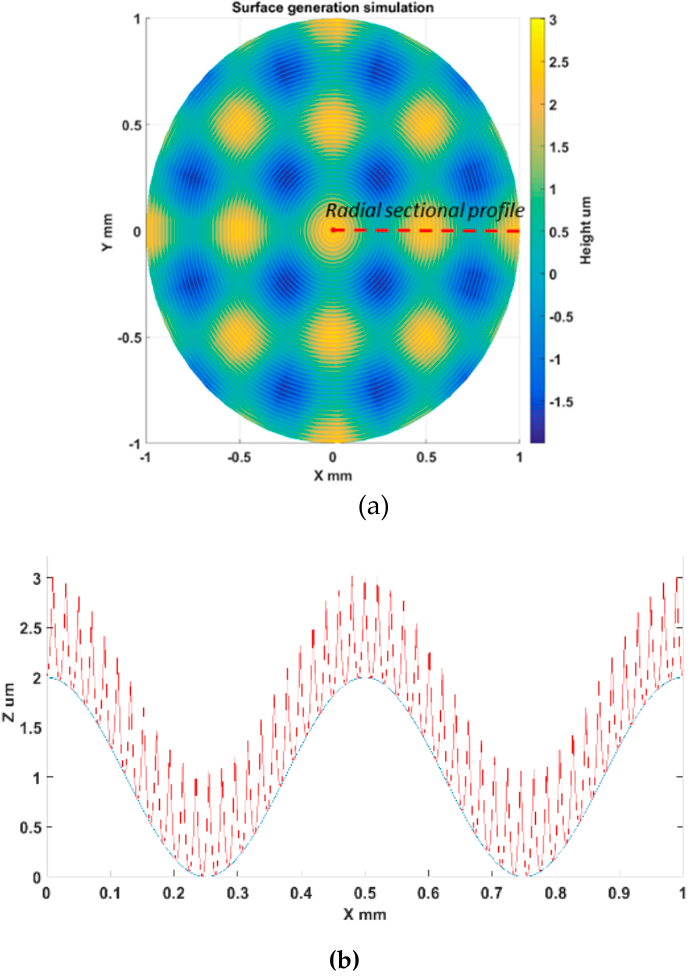
Figure 14. Simulation example of areal surface topography generation: ( a ) Surface generation simulation; ( b ) Radial section profile topography (0 degrees).